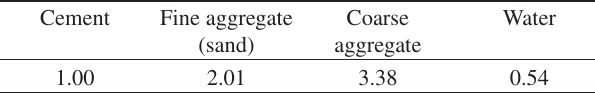
Table 3. Blend ratio of concrete (in weight basis).